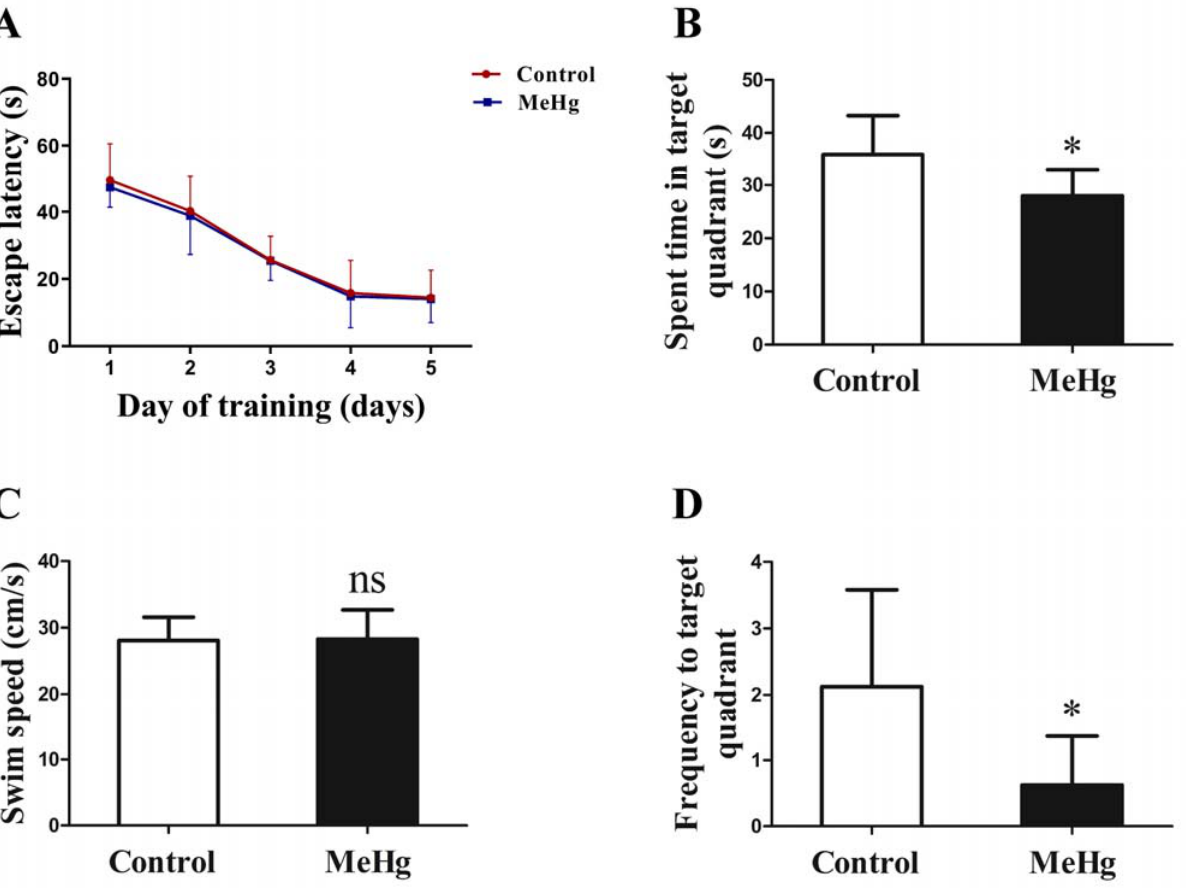
Figure 2. The influence of MeHg exposure on spatial learning and memory in the Morris water maze, including the escape latencies of the groups during the training trials ( A ), time spent in target quadrant ( B ), swimming speed ( C ), and the frequency of entering the target quadrant ( D ). The data are expressed as mean ± SD for eight rats per group. ns, no significance compared to the control group, p > 0.05. * p < 0.05, significant difference compared to the control group.